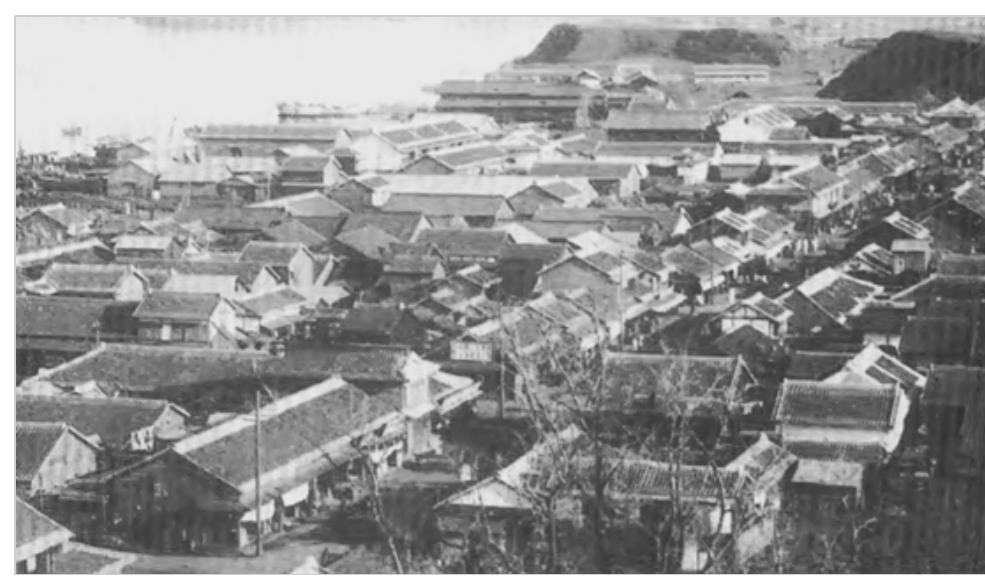
Figure 2. Foreign settlement in Gunsan in the 1920s .